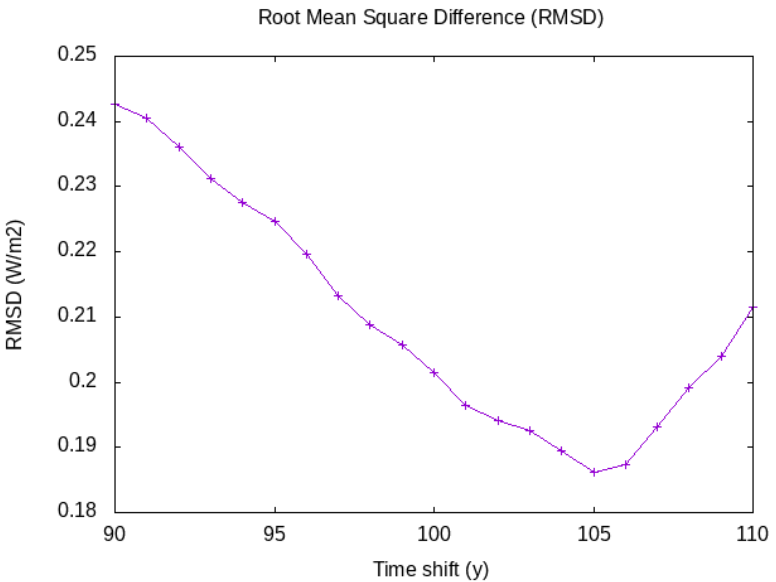
Figure 6. Root Mean Square Difference (RMSD) as a function of the time shift T (cid:48) between the last 100 years of the 11 year running mean TSI variation and the 2 earlier periods, see Equation